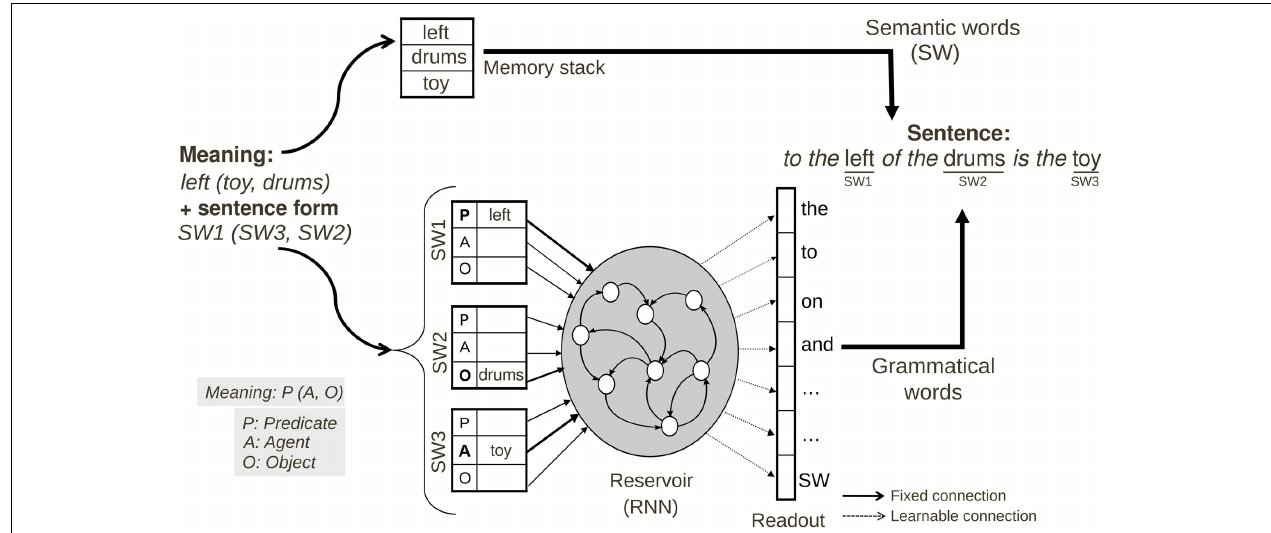
FIGURE 4 | Neural production model for Scene Description task. The input has 2 components: (1) meaning format < Predicate(Agent, Object)—left(toy, drums) > corresponding to relation toy to the left of drums , and (2) construction format with < SW1—Predicate, SW2—Object, SW3—Agent > which could be written in a compact way as SW1(SW3, SW2).